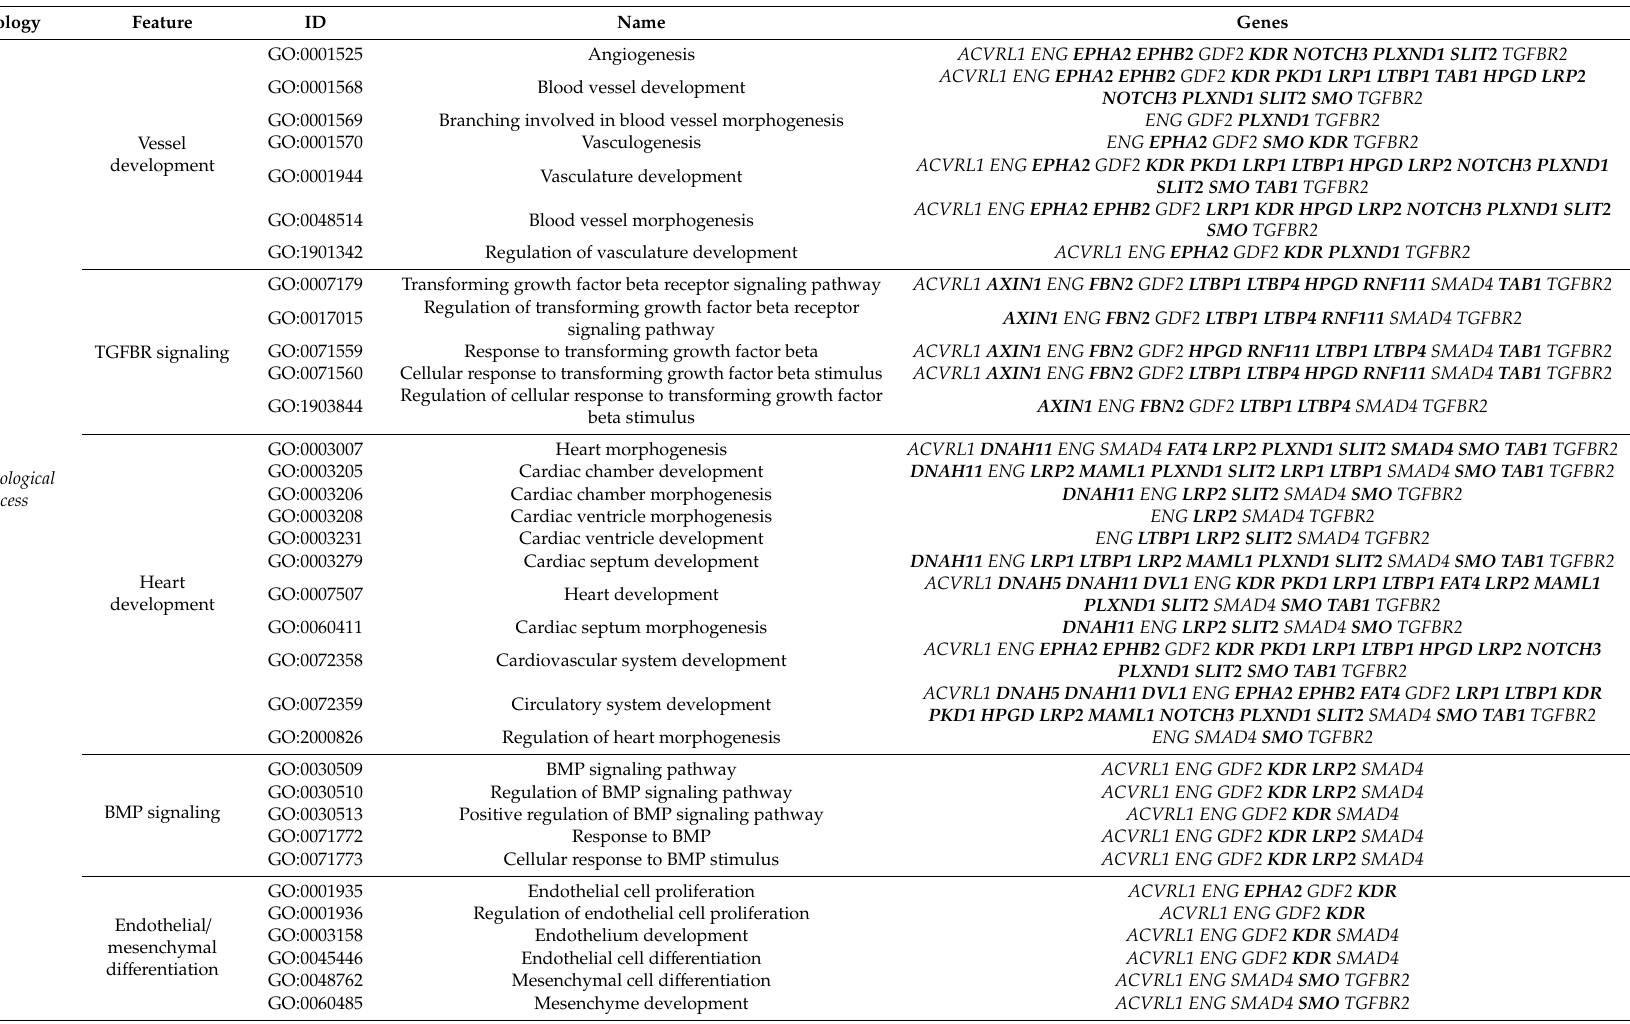
Table 2. Genes prioritized by ToppGene